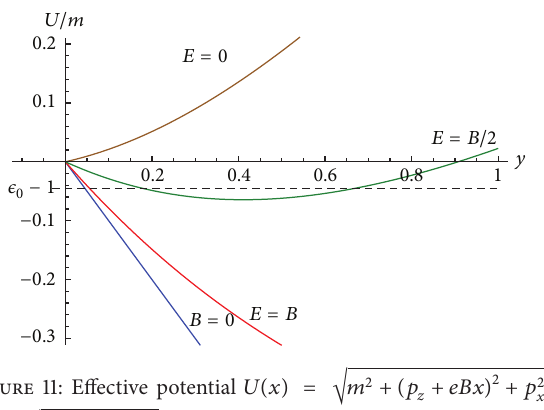
Figure 11: Effective potential 𝑈(𝑥) = √𝑚 2 + (𝑝 𝑧 + 𝑒𝐵𝑥) 2 + 𝑝 2 𝑥 − 𝑒𝐸𝑥 − √𝑚 2 + 𝑝 2 + 𝑝 2 𝑝 = 0, 𝑝 = 𝑚/6, and 𝐵 = 𝑚 (except the 𝑥 𝑧 𝑥 𝑥 for blue line where 𝐵 = 0 ). The width of the potential barrier decreases with 𝐸 and increases with 𝐵 . 1 − 𝜖 0 corresponds to the binding energy in units of 𝑚